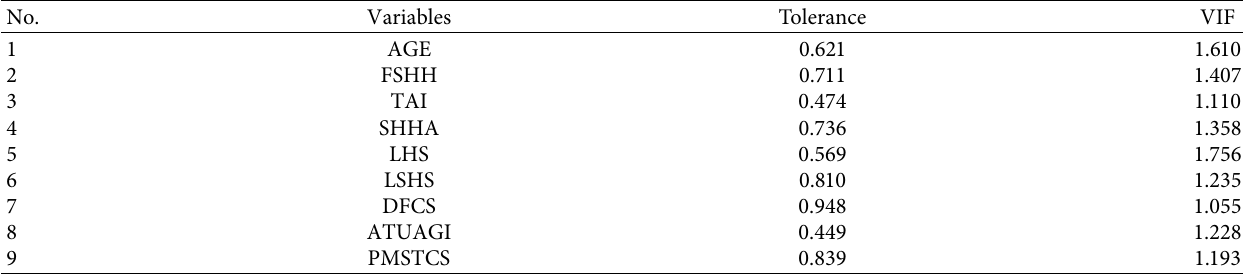
Table 11: Variance inflation factor for continuous